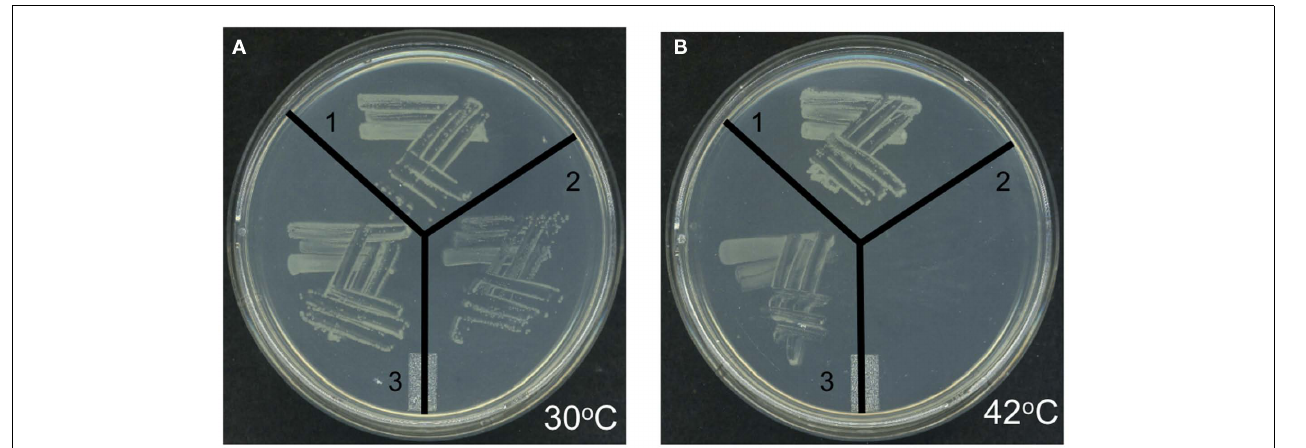
(3).These strains were grown at the permissive temperature, 30˚C (A) and non-permissive temperature, 42˚C (B) . Complementation is evidenced by the fact that the lpxA-2 (ts) strain expressing the At4g29540 cDNA grew at 42˚C, whereas this mutant strain transformed with the control empty vector failed to grow at this non-permissive